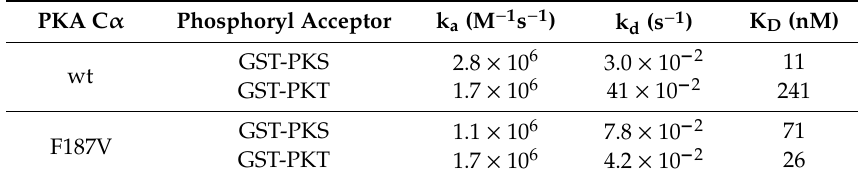
Table 4. Kinetic data for the formation of the Michaelis complex with AMP-PCP and MnCl 2 . Data derived from SPR analyses of the interaction between PKA C α wt or F187V (Figure S9D,E) and GST-PKS or GST-PKT, respectively, in the presence of 0.2 mM AMP-PCP and 1 mM MnCl 2